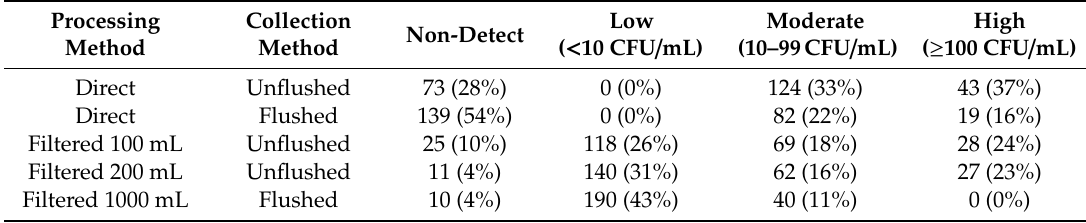
Table 3. Category level of Legionella concentration based on processing and collection